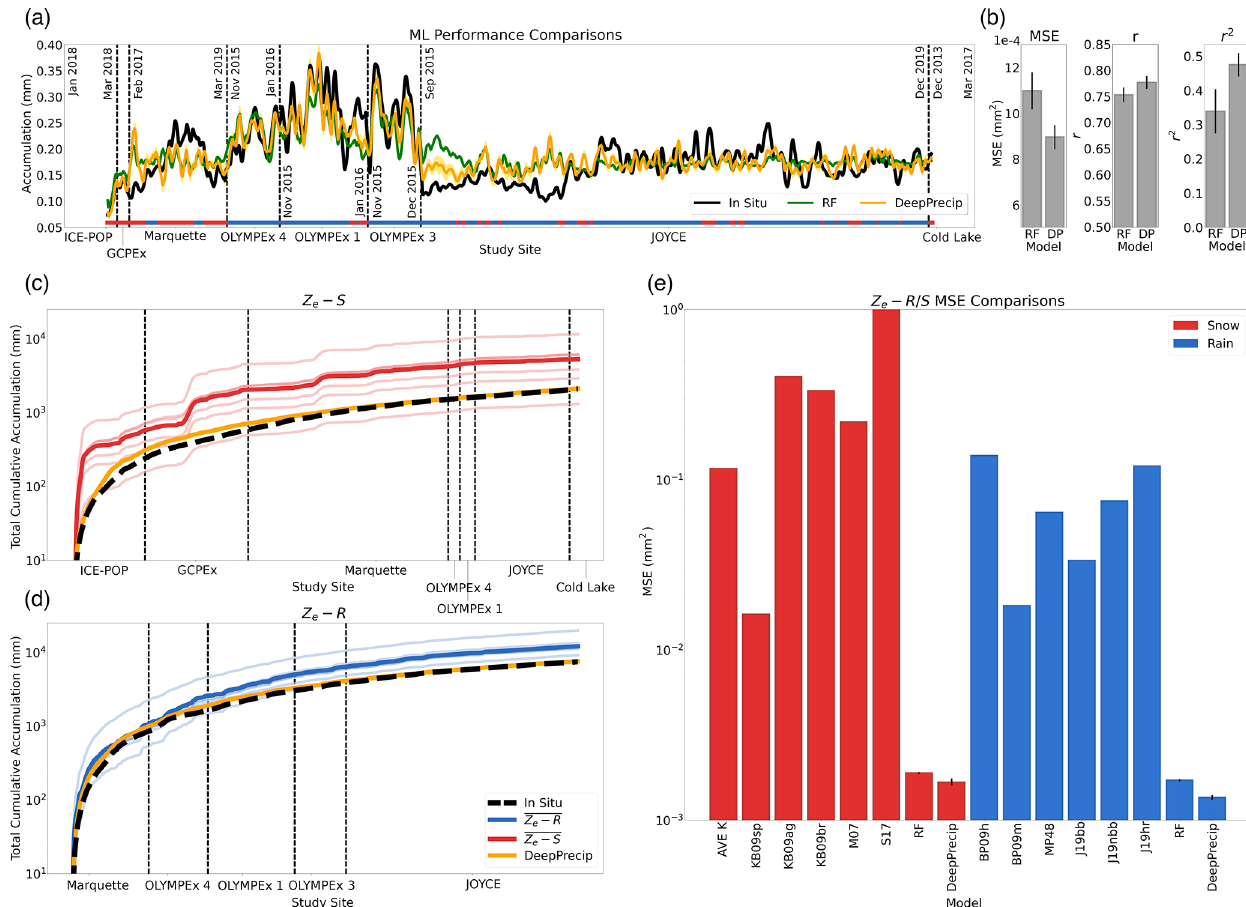
Figure 4. Performance comparisons between DeepPrecip (DP), an RF, and an ensemble of power law-derived retrievals of surface precipi- tation. (a) Running mean (window size 500 time steps) of accumulation for all sites with Pluvio2 measurements in black, RF estimates in green, and DeepPrecip in yellow. Data is sorted by station and then time, with each station separated by a dashed vertical line. One standard deviation from 50 dropout runs per cross-validated instance is shown in the shaded regions (most notable in DP estimates at the start of JOYCE). (b) Performance statistics for RF/DeepPrecip accuracy, including MSE, Pearson correlation ( r ), and r 2 with error bars showing one standard deviation. (c) Time series of total accumulation estimates over the full observation period for all Z e − S relationships (individual light red lines) and DeepPrecip. The mean of the Z e − S relationships is shown in bold. (d) The same as in (c) but for Z e − R . (e) Phase- partitioned log-scale MSE values between each model and in situ observations from 50 model realizations. Note that S17 MSE values extend beyond the top of the graph to 10 1 mm 2